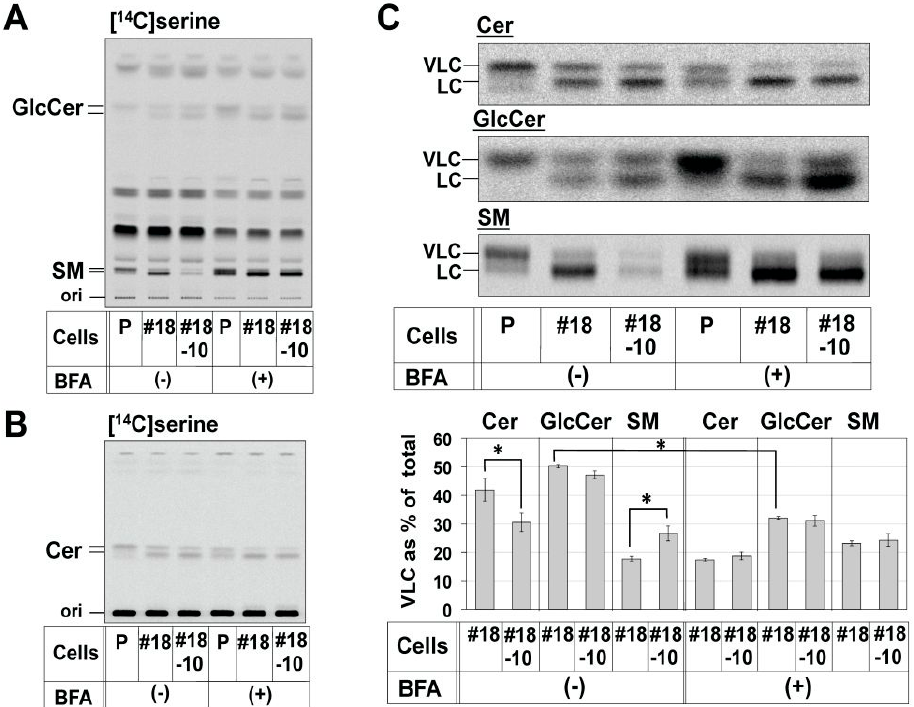
Figure 5. Effects of CERT disruption and Brefeldin A (BFA) treatment on the proportion of VLC species in sphingolipids. ( A , B ) Metabolic labeling of sphingolipids with radioactive serine in the parent cells (P), TAL-CERS2#18 clone (#18), and TAL-CERS2#18-CERT#10 clone (#18-10). Cells were cultured with [ 14 C]serine in the presence (+) or absence (-) of BFA for 2 h, and lipids extracted from the cells were separated by Method 1 for GlcCer and SM in ( A ) and Method 3 for ceramide analysis in ( B ). The darker images are shown in Figures S7A and S7C; ( C ) comparison of the proportion of VLC of ceramide, GlcCer, and SM shown in ( A , B ). The method used is as described in Figure 2B. The enlarged and darker images of [ 14 C]serine-labeled ceramide, GlcCer, and SM shown in ( A , B ) are aligned. The proportions of VLC-containing lipids are expressed as described in Figure 2B: mean percentage ± SD obtained from three independent experiments. The mean percentage in the TAL-CERS2#18 clone was compared with that in the TAL-CERS2#18-CERT#10 clone (#18-10) and that in the BFA-treated TAL-CERS2#18 clone, and the Bonferroni corrected Student’s t -test was used for the multiple comparisons. * p < 0.025.